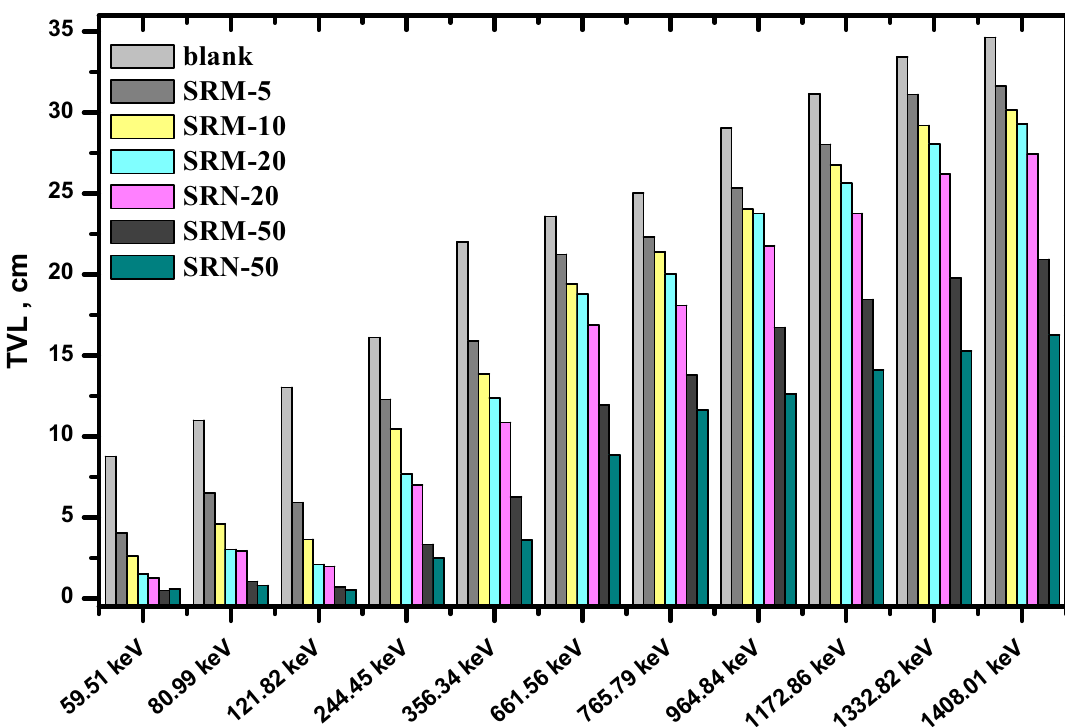
Figure 10. TVL of pure silicon rubber, micro, and nano PbO at different energy.